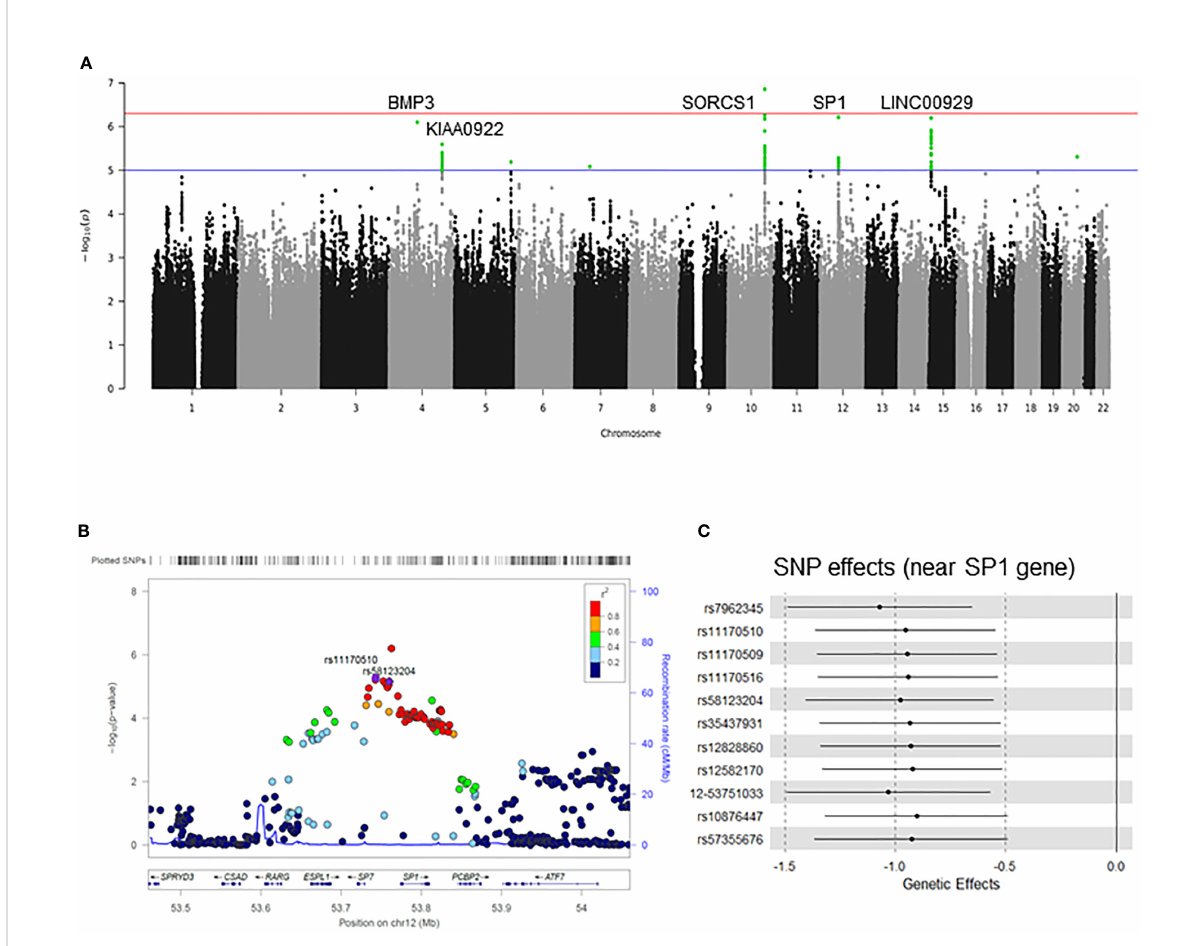
FIGURE 1 Genome-wide association study (GWAS) on cold sensitivity. (A) Manhattan plot and quantile-quantile plot for the GWAS of cold sensitivity. The blue horizontal line indicates P values<10-5, while the red horizontal line indicates P values < 10-7. The loci with well-characterized genes are indicated close to the association peaks. (B) LocusZoom plot of rs11170510 and rs58123204 in the SP1 gene. In these plots, each point represents a – log(P) value in the linear regression analysis as a function of genomic position (NCBI Human Genome Build 37). The color codes of all the other SNPs represent LD, with the lead SNP (estimated based on hg19/1000 Genomes Mar 2021 ASN): red, r2 ≥ 0.5; gold, 0.6 ≤ r2 < 0.8; green, 0.4 ≤ r2 < 0.6; cyan, 0.2 ≤ r2 < 0.4; blue, r2 < 0.2; gray, r2 unknown. (C) Forest plot showing the genetic effect size between single nucleotide polymorphisms (SNPs) and cold